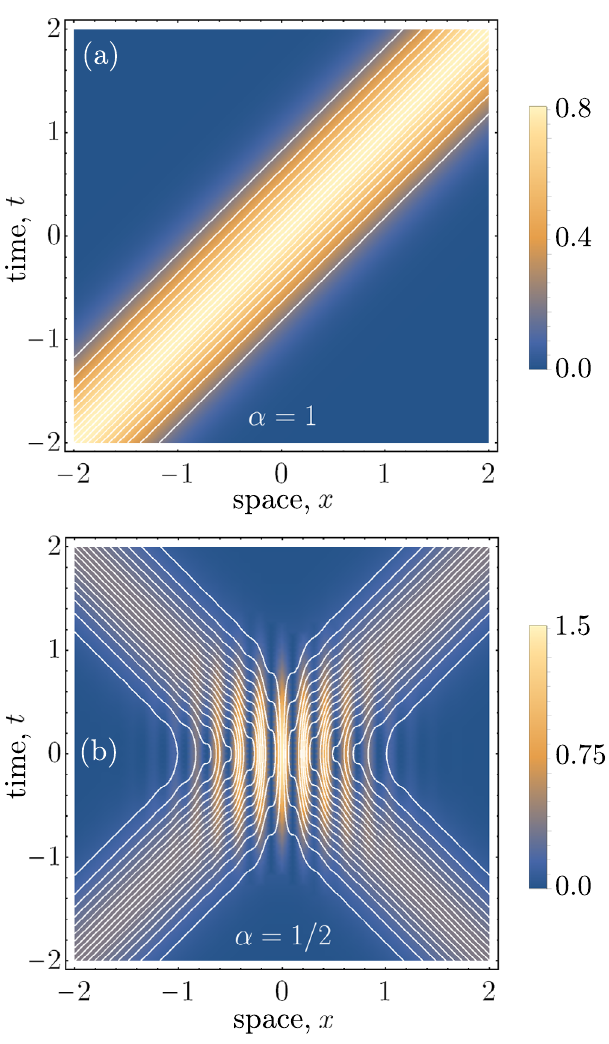
Fig. 2 Plots of the Bohmian trajectories with k 0 / σ = 15. In the background of both plots is the quantum-mechanical prediction for the probability density of the particles, ρ K ( x , t ). In ( a ), the trajectories are completely right- moving and maintain a Gaussian distribution, according to the initial conditions that we have chosen to match the wavefunction density. In ( b ), we have considered the superposition case, wherein the photon follows a path that matches the interference pattern predicted by ρ K ( x , t